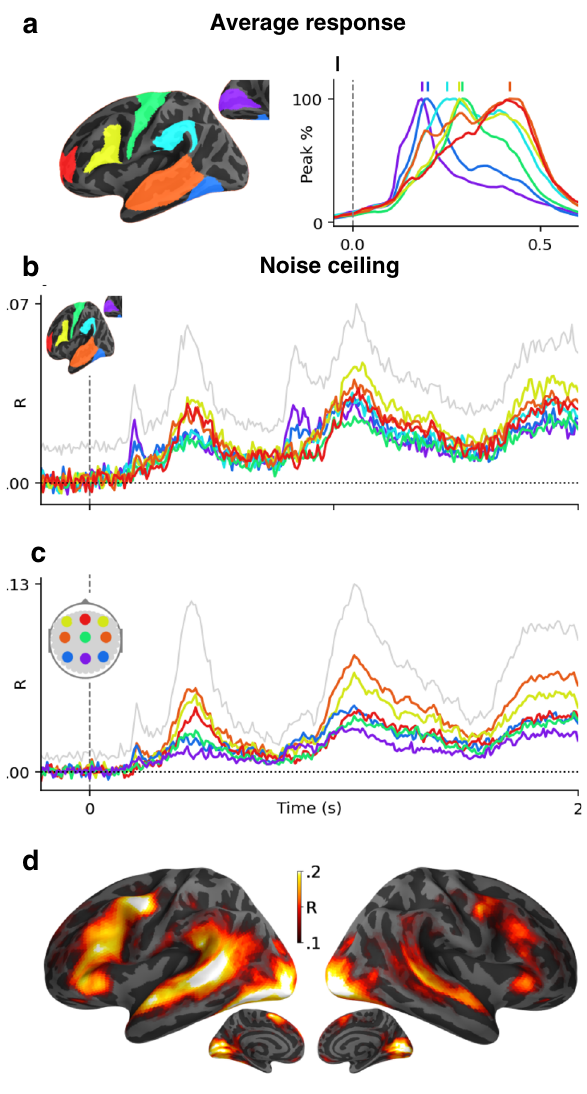
Fig. 2 Average and shared response modeling (or noise ceiling). a Grand average MEG source estimates to word onset ( t = 0 ms) for seven regions typically associated with reading (V1: purple, M1: green, fusiform gyrus: dark blue, supramarginal gyrus: light blue, superior temporal gyrus: orange, infero-frontal gyrus: yellow and fronto-polar gyrus: red), normalized to their peak response. Vertical bars indicate the peak time of each region. The full (not normalized) spatio-temporal time course of the whole-brain activity is displayed in Supplementary Movie 1. b MEG shared response model (or noise ceilings), approximated by predicting brain responses of a given subject from those of all other subjects. Colored lines depict the mean noise ceiling in each region of interest. The gray line depicts the best noise ceiling across sources. c Same as b in sensor space. d Shared response model of fMRI